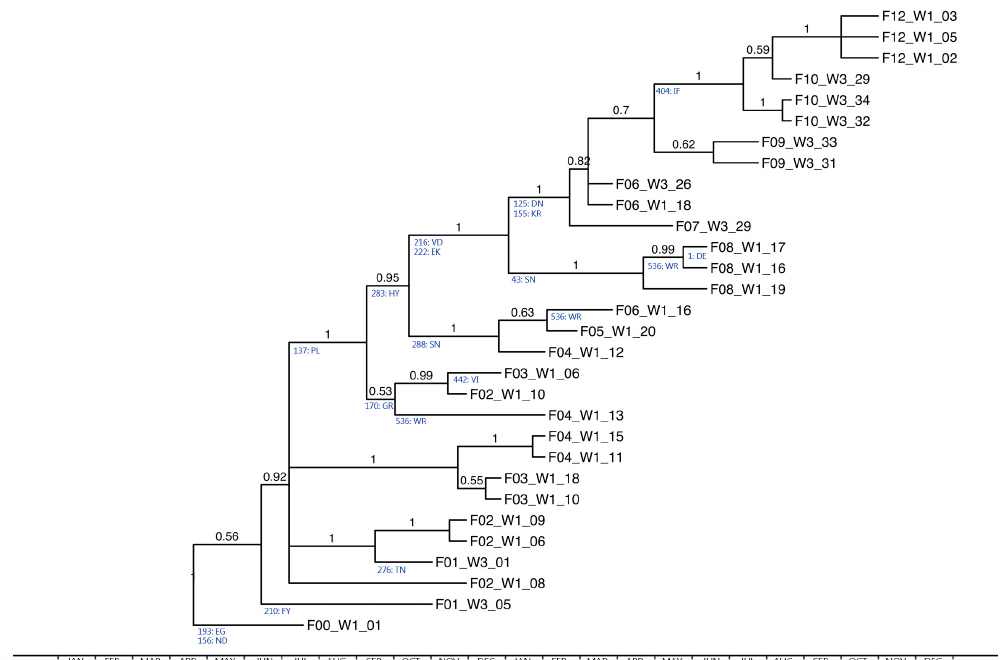
Figure 2. Bayesian strict molecular clock tree of the hemagglutinin (HA) sequences. The x-axis represents time in months from 2017–2019. Branch labels represent posterior clade probabilities. Ancestral amino acid changes are indicated below the branches on which they most probably occurred, with DTLC numbering.